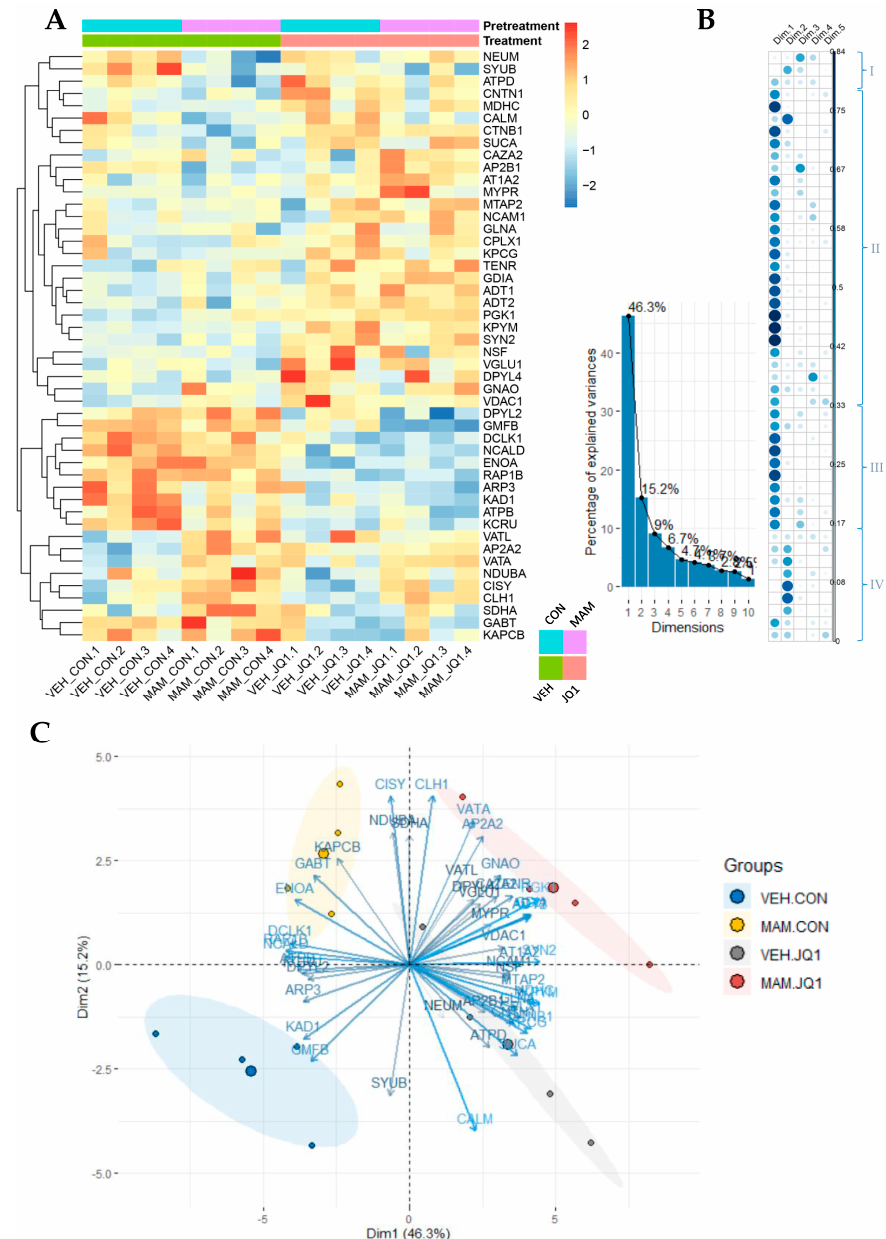
Figure 9. Proteomics study in the adult medial prefrontal cortex of males in the MAM-E17 model of schizophrenia. The rats were exposed to JQ1 or vehicle (CON) in early adolescence (P23–P29) and the analyses were performed in rats at P110. ( A ) Heatmap view of 48 differentially expressed proteins across groups ( p < 0.050) identified from iTRAQ analysis. The colour scale illustrates the relative expression level of each protein across the 4 samples (biological replicates of mPFC) of each group: VEH-CON (1–4), MAM-CON (1–4), VEH-JQ1 (1–4), and MAM-JQ1 (1–4). Red and blue indicate higher and lower expression than the median expression value, respectively. The colour palette (right bar) represents standardised protein expression values (from red: upregulated, to blue: downregulated proteins). ( B ) Correlogram of the representation of the differentially expressed proteins depicted in the heatmap as well as their contribution to the principal components (Dim1–Dim5). Protein clusters (I–IV) on the right correspond to proteins visualised on the heatmap and correlogram. ( C ) PC biplot of the differentially expressed proteins. On the whole, the first component is linked to clusters affected by adolescent JQ1 treatment (cluster II and III). The second component corresponds to clusters affected by prenatal MAM administration (cluster I and IV). The first two principal components enabled us to visualise proteins specific for each treatment as well as the interaction between MAM and JQ1 administration. Abbreviated protein names are defined in Table